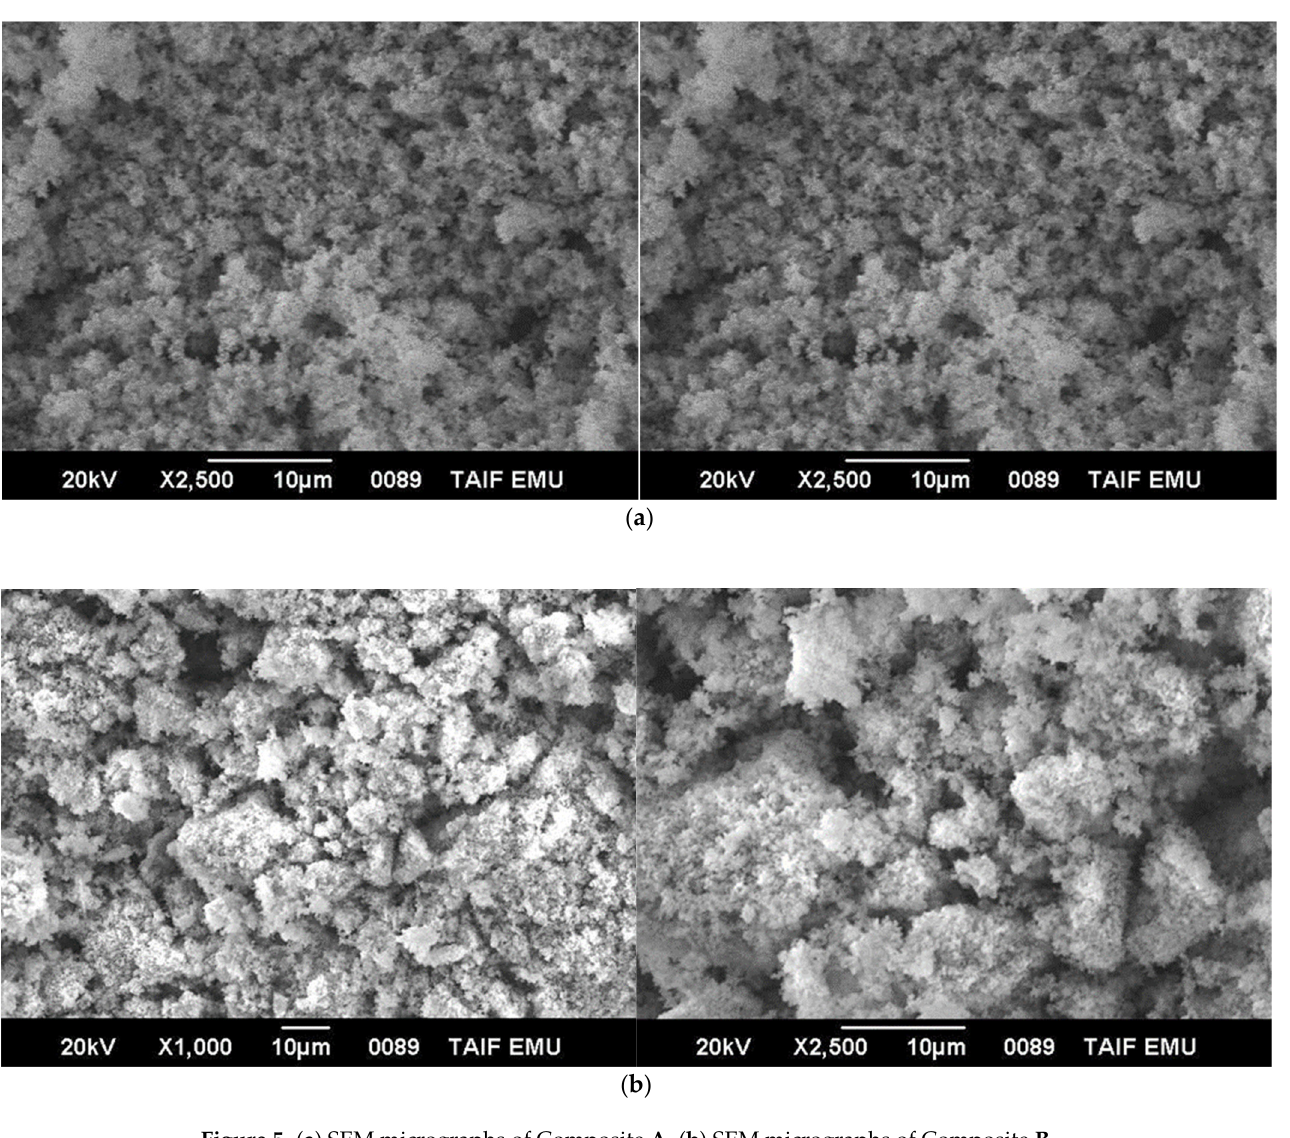
Figure 5. ( a ) SEM micrographs of Composite A . ( b ) SEM micrographs of Composite B. Table 1. Percentage of elements of Composites A and B observed by EDX analysis.